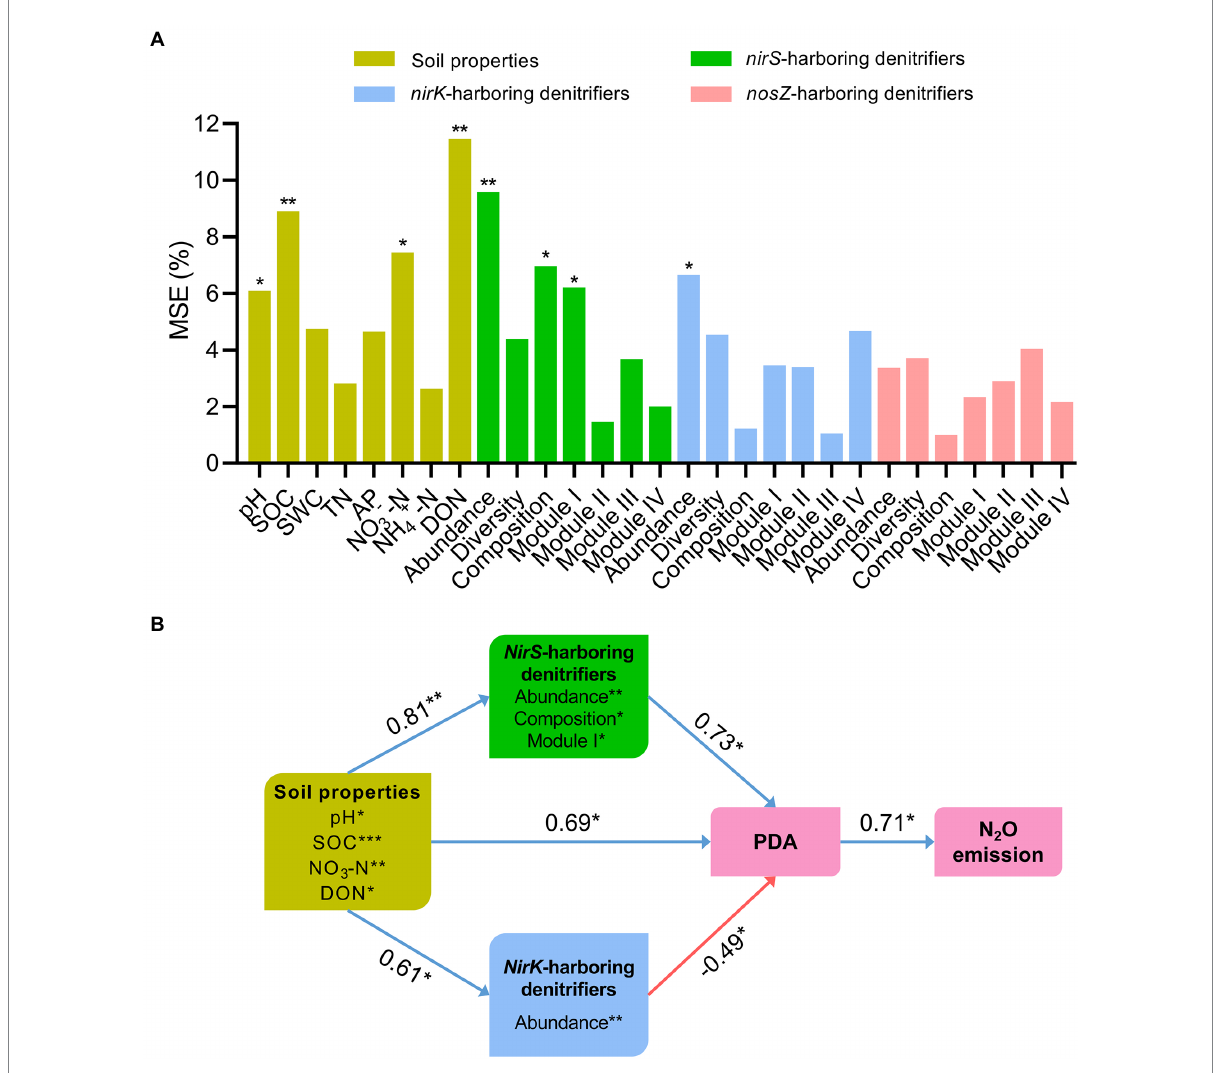
FIGURE 6 Random forest modeling was used to assess the main predictors of potential denitrification activity (PDA; A ). Soil properties is represented by pH, soil organic carbon (SOC), soil water content (SWC), total nitrogen (TN), available phosphorus (AP), nitrate nitrogen (NO 3 − − N), ammonia nitrogen (NH 4+ − N), and dissolved organic nitrogen (DON). The denitrifying communities are represented by abundance (the copy numbers of genes), diversity (Chao1 richness), composition (first principal coordinates, PC1) and network modules (module eigengenes). The significant predictors are further chosen to perform the structural equation modeling (SEM). SEM shows the direct and indirect effects of soil properties and the denitrifying communities on potential denitrification activity (PDA) and N 2 O emission across fertilization treatments (B) . Blue arrows indicate positive correlations, and red arrows indicate negative correlations. The numbers associated with arrows indicate the correlation coefficient. Widths of arrows indicate strength of significant standardized path coefficients. * p < 0.05; ** p <